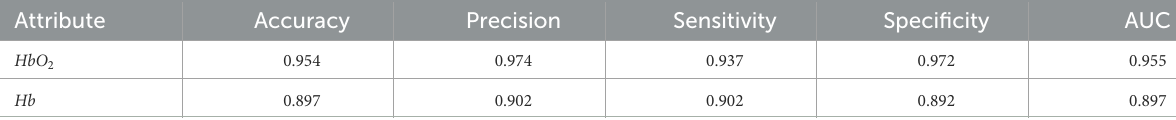
TABLE 2 Comparison of experimental results for different attributes.